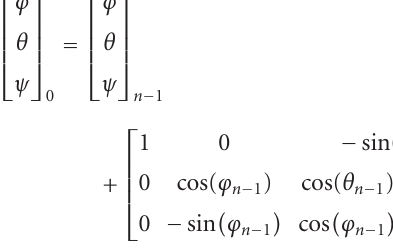
Figure 7: IMM L estimator